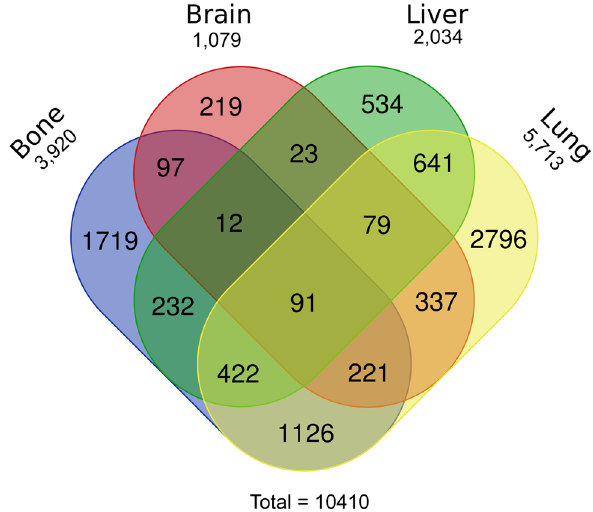
Figure 1. Venn diagram of the distribution of distant metastatic sites. There were four types of metastatic sites in 10,410 patients. Lung metastasis was the most common forms of metastasis).